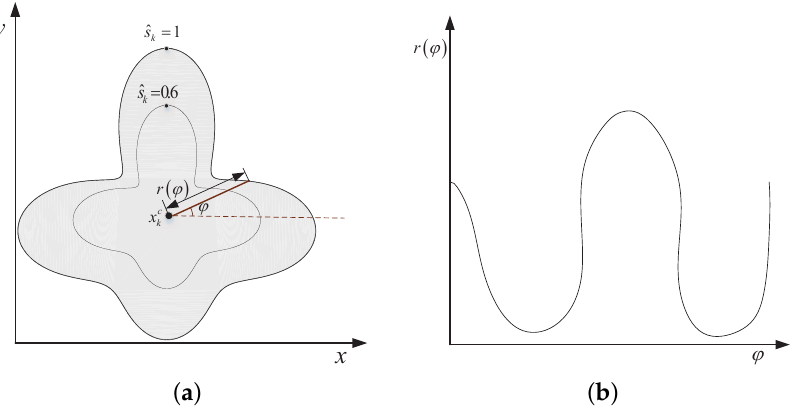
Figure 3. Representation of a star-convex shape using a radial function. ( a ) Star-convex extended object. ( b ) Radial function.